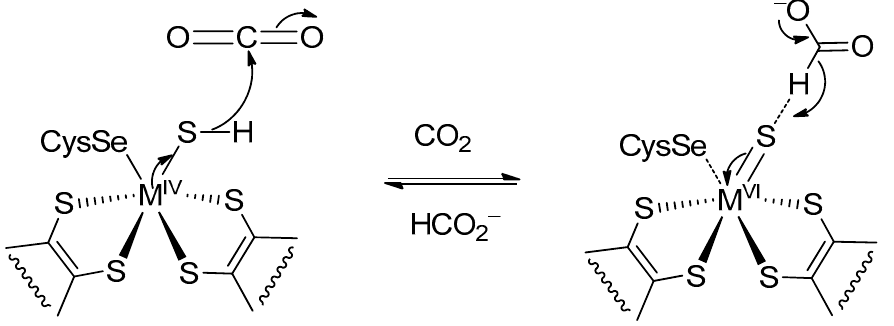
Figure 2. Structures of PGD and MPT ( top ) and active site of FDHs: M = Mo/W ( bottom ). The presence of the selenocysteine ligand in the reduced form is debated.